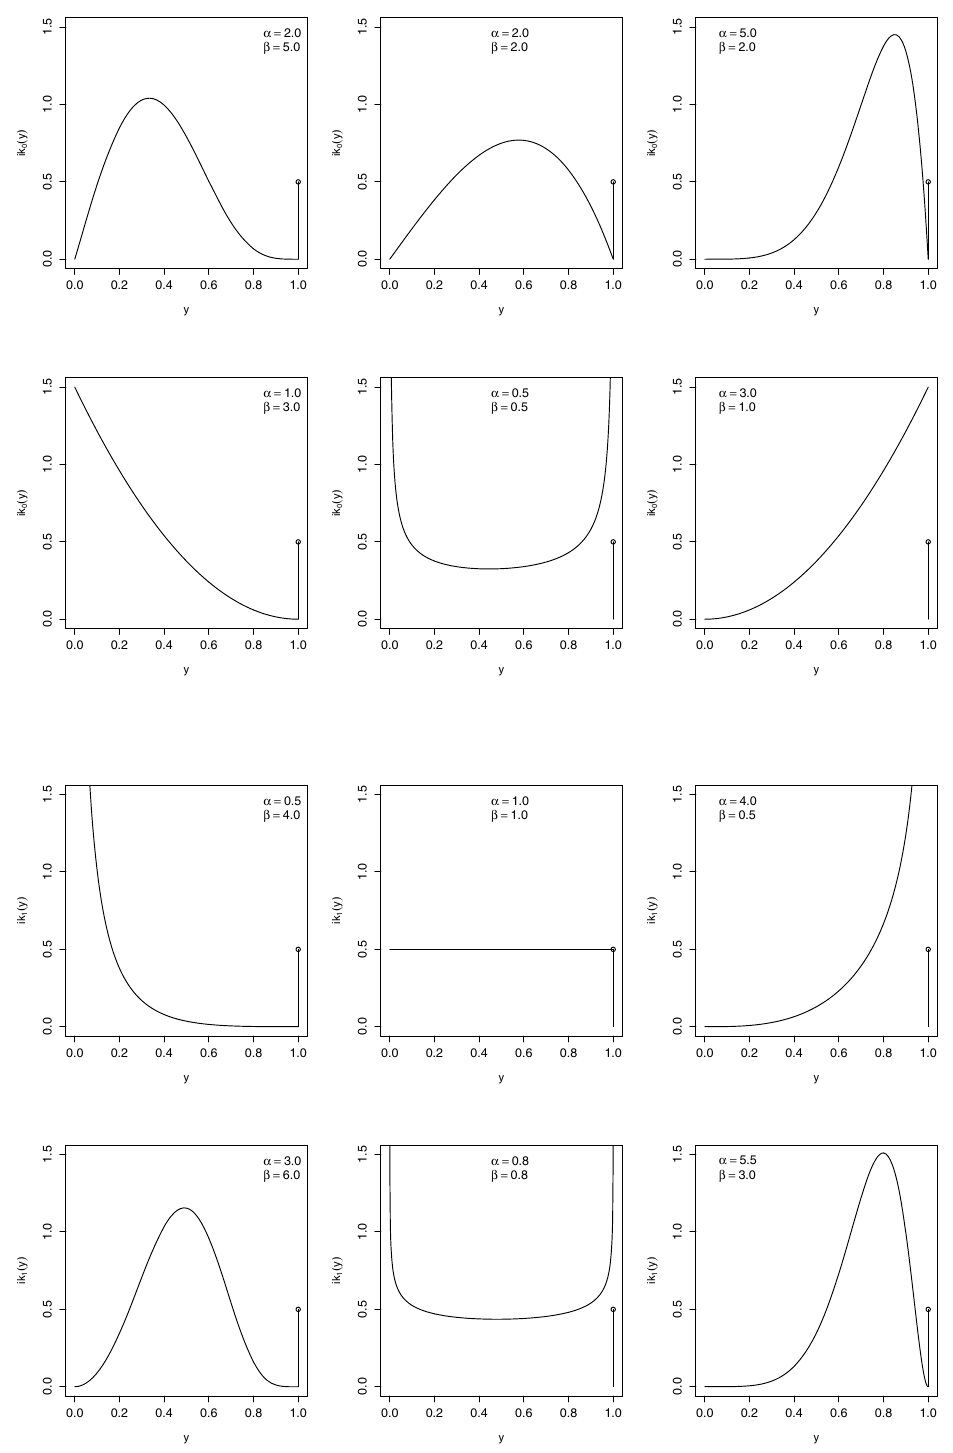
Figure 1 - Inflated Kumaraswamy densities at c = 0 and c = 1 , λ = 0.5